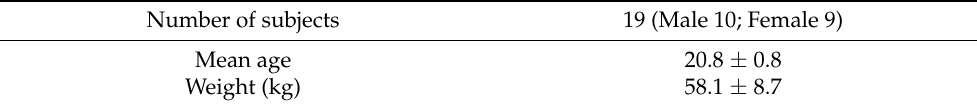
Table 2. Subject data, mean ± SD.